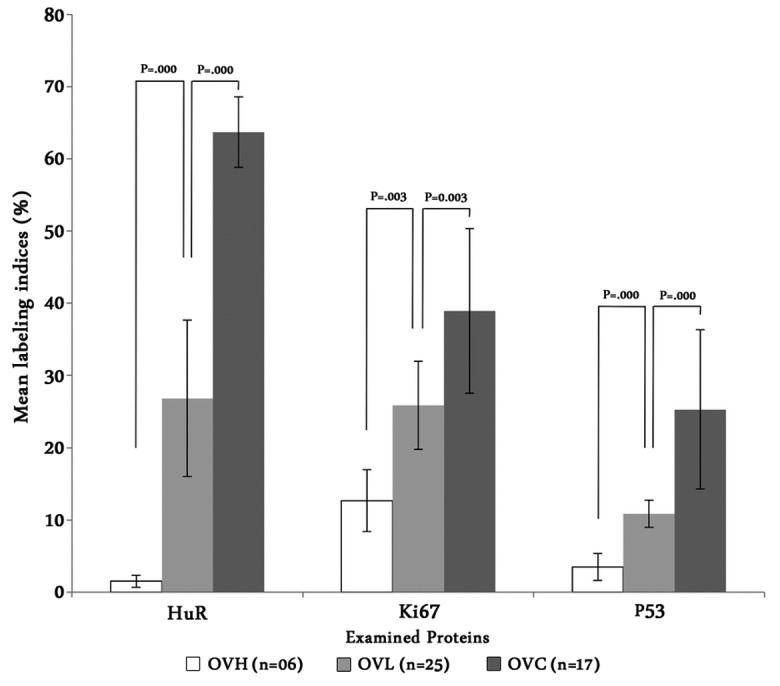
The mean labeling indices (LIs) (%) of the examined proteins. The ratio of immuostained-positive cells for p53, Ki67 or HuR to the total number of cells counted was evaluated for each case of oral verrucous hyperplasia (OVH), oral verrucous carcinoma (OVC) and oral verrucous lesion (OVL). The mean LI for the respective lesions was calculated and compared. Bars show standard deviation (SD).